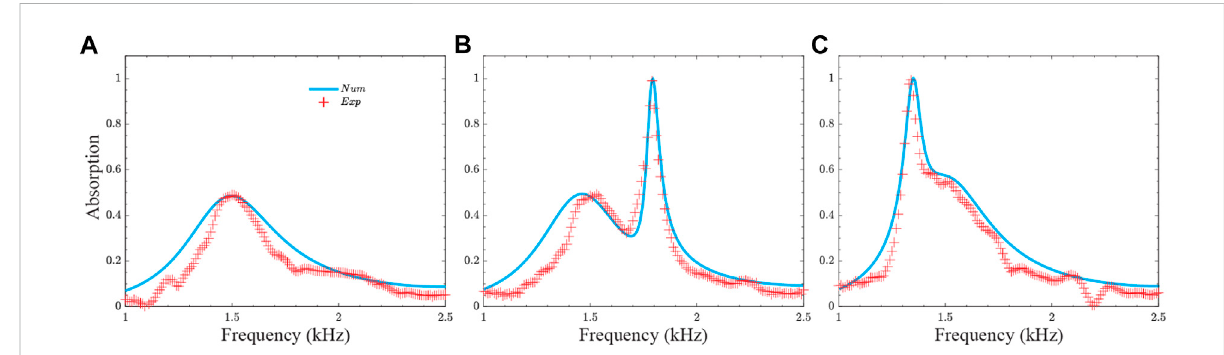
FIGURE 4 Experimentally measured absorption spectra (read plus symbols) compared to numerical simulations (blue solid lines). The absorption spectra with (A) an open circuit and an LR-shunted circuit with (B) L =5.8 H and R =1.0 k Ω (C) L =9.7 H and R =2.9 k Ω